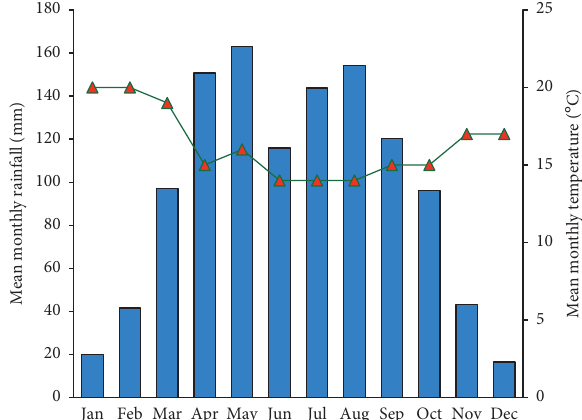
Figure 2: Monthly average rainfall (mm) and temperature ( ° C) in the study